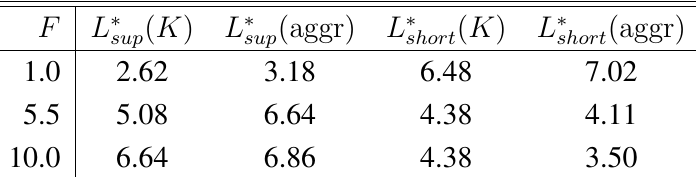
Table 1. Maximum period lengths (in days) for continuous supply ( L ∗ ( L ∗ ) at three different total power factor F . Wind power records P short one P [see Equation (1)] are evaluated in years Σ